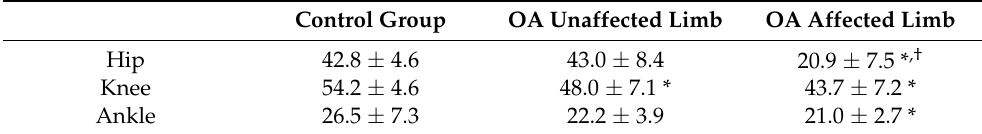
Table 4. Dynamic Range of Motion during gait (in degrees). Values are expressed as mean ±